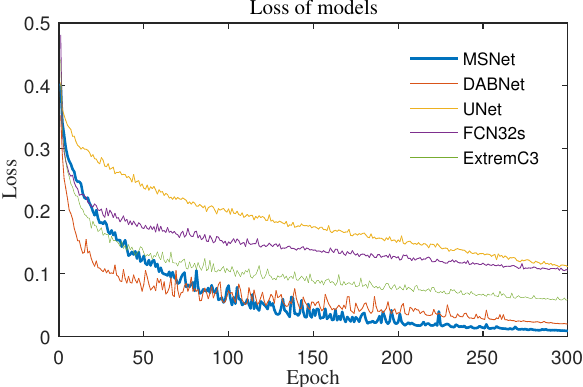
Figure 13. The MIoU of the models.